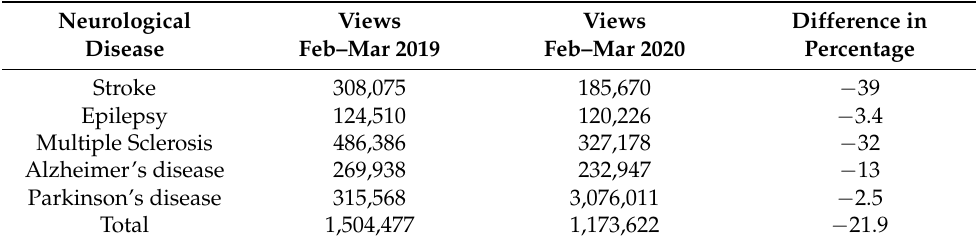
Table 1. Total views of the English Wikipedia articles on each neurological disease in February and March 2019 and the same time period in